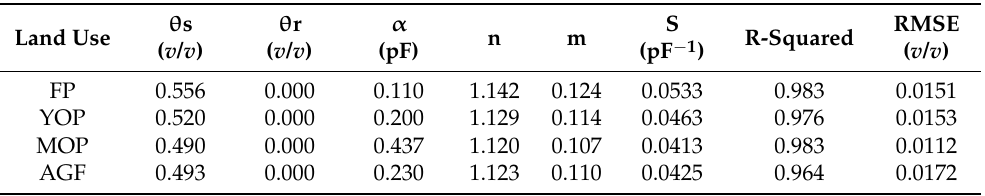
Table 2. SWRC best-fit parameters and S